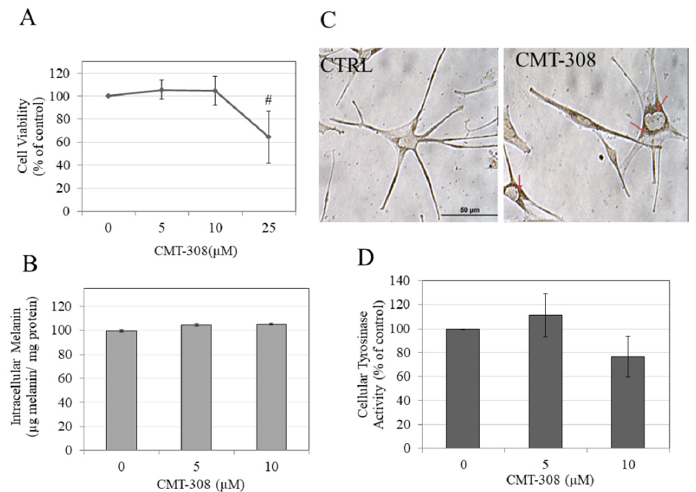
Figure 6. ( A ) human epidermal melanocytes-darkly pigmented (HEMn-DP) cell viability after treatment with CMT-308 for 72 h as measured by MTS assay; # p < 0.01 vs. Ctrl, One-way ANOVA with Dunnett’s test; data are mean ± SD of three independent experiments; ( B ) intracellular melanin levels in HEMn-DP cells treated with CMT-308 for 72 h; data are mean ± SD of a representative independent experiment on triplicate samples; ( C ) representative bright-field images of HEMn-DP cells in control (Ctrl) and CMT-308 (10 µM)-treated group; red arrows show perinuclear aggregation of melanosomes in the CMT-308-treated group; objective magnification 40×; ( D ) tyrosinase activity in HEMn-DP cellular lysates after treatment with CMT-308 for 72 h; data are mean ± SD of at least two independent experiments. CMT-308 did not a ff ect intracellular melanin levels in HEMn-DP cells at 5 or 10 µ M (Figure